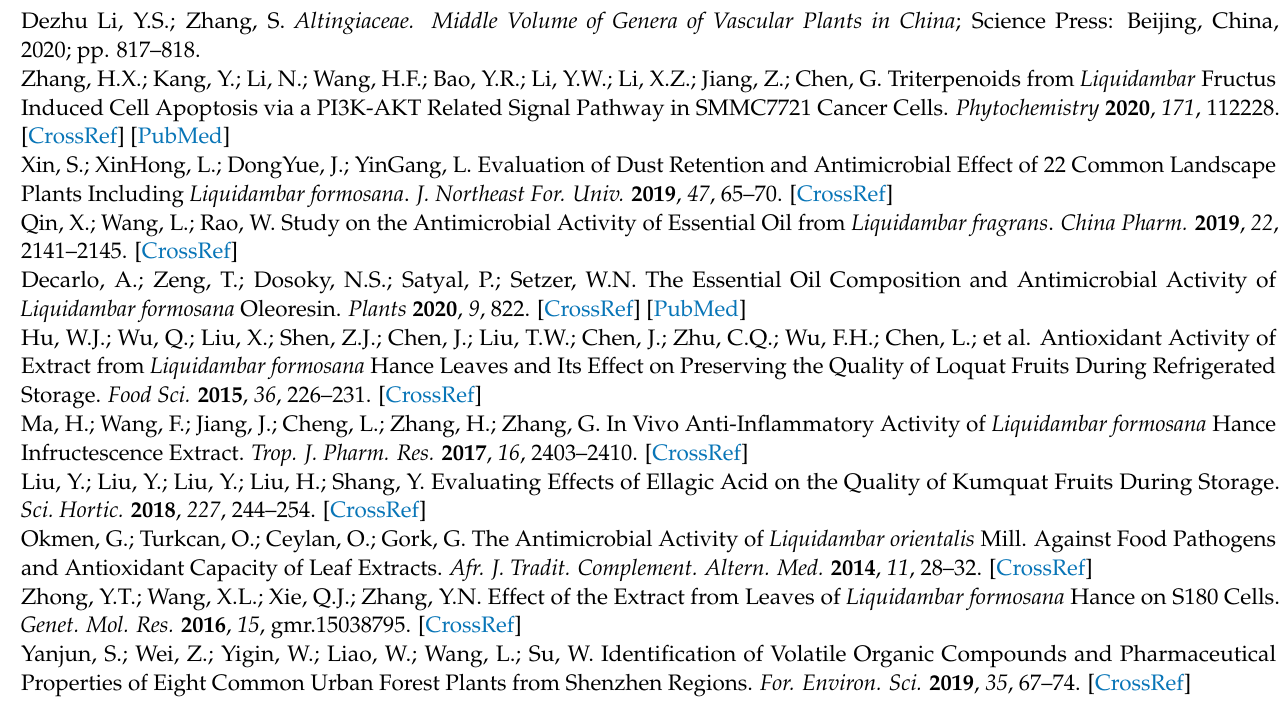
Figure S2: shows ten predicted motifs; Table S1: Primer information used in qRT-PCR assays of five genes related to monoterpene pathways; Table S2: GC–MS detection data of the metabolome; Table S3: The expression of all the genes in the transcriptome.; Table S4: GO functional annotation and KEGG enrichment analysis data of DEGs.; Table S5: qRT-PCR results.; Table S6: Interaction network data between the 4 TPSs of L. formosana , α -pinene, and β -pinene.; Table S7: Provenance and accession number of terpene